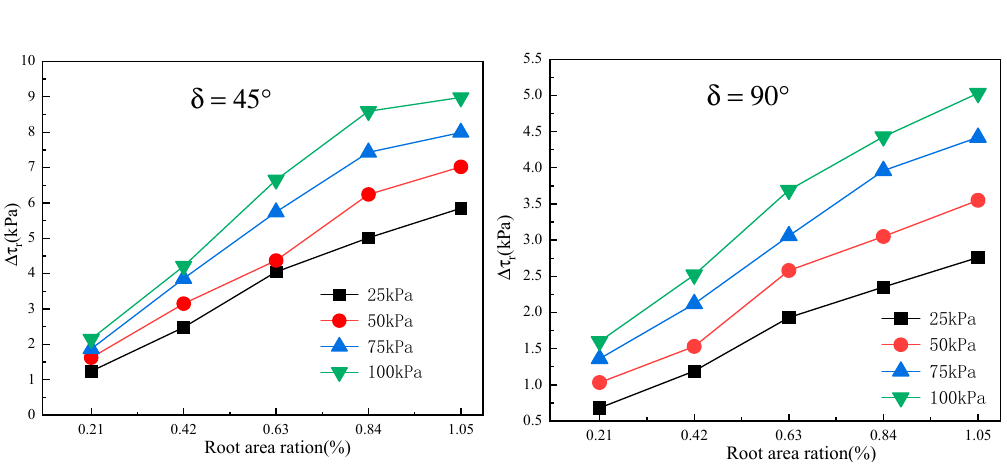
τΔ of di ff erent root-bearing soil samples. Figure 15. Roots reinforcement ∆ τ r of different root-bearing soil